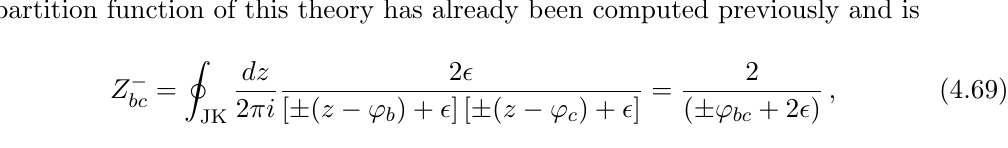
(cid:10) (cid:0) (cid:1)(cid:11) T ( U + ) 2 ( U (cid:0) ) 2 1 1